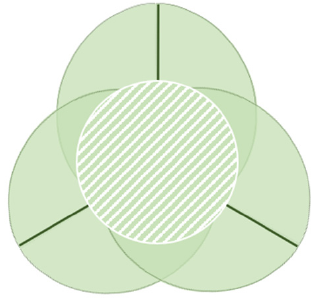
Figure 7. Idealized signal coverage diagram.